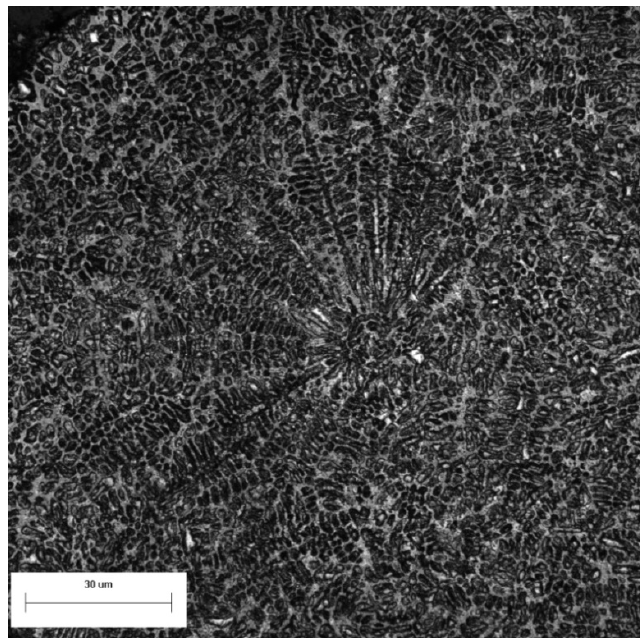
Figure 10. Microstructure of the powder.